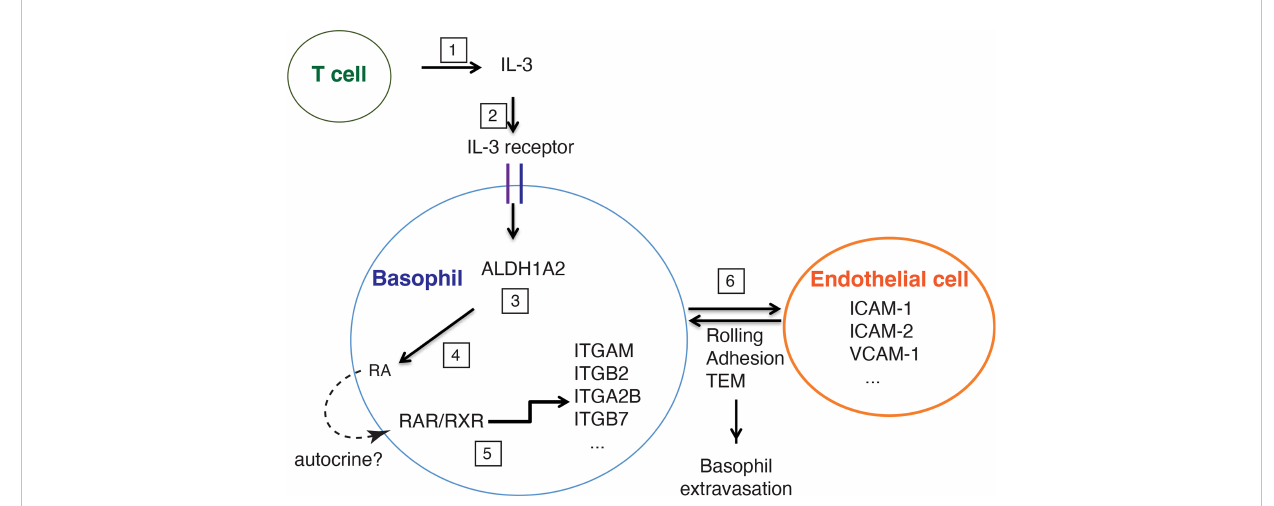
FIGURE 8 A schematic representation of the role of T cell-derived IL-3 in mediating FITC-induced basophil extravasation to ACD skin. Upon FITC treatment, T cells secrete IL-3 (1), which binds to IL-3 receptor complex on basophils (2), and induces expression of ALDH1A2 (3), leading to the production of retinoic acid (RA) by basophils (4). In turn, RA activates RAR/RXR receptor heterodimer in an autocrine manner, which upregulates the expression of integrins such as ITGAM, ITGB2, ITGA2B, ITGB7 by basophils (5). The interaction between integrins (expressed by basophils) and their ligands (expressed by endothelial cells, such as ICAM-1, ICAM-2, VCAM-1) is crucial for baso- phil extravasation to ACD skin through rolling, adhesion and trans-endothelial migration (TEM)